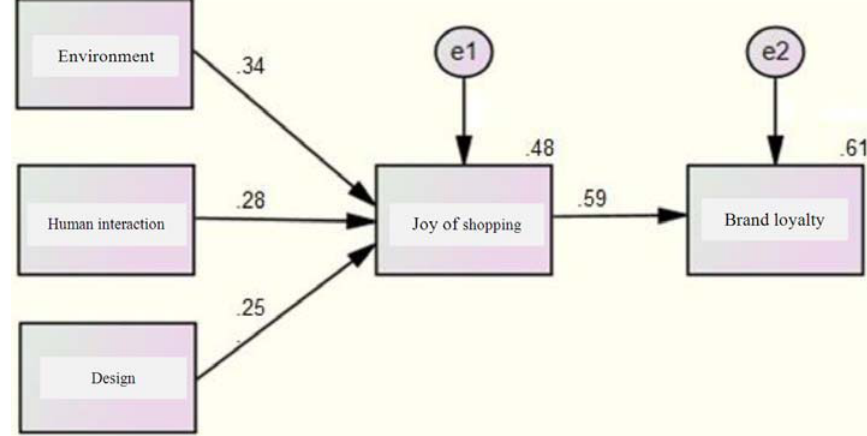
Fig. 5. Path analysis of conceptual